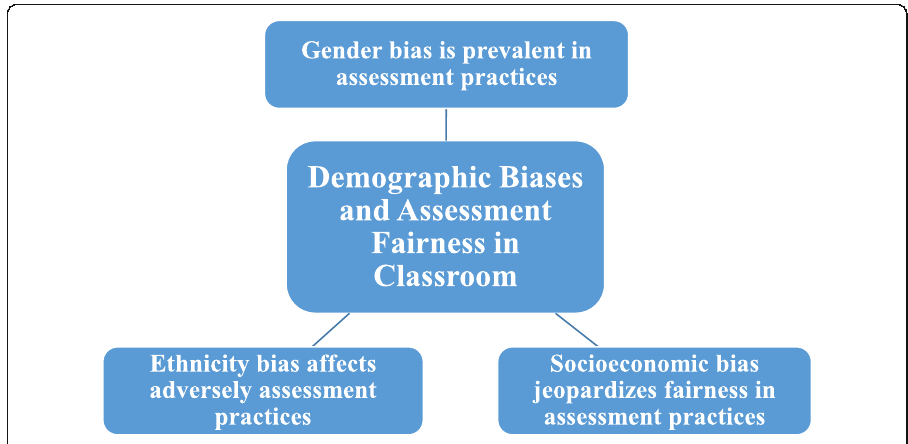
Fig. 1 Demographic biases and assessment fairness in